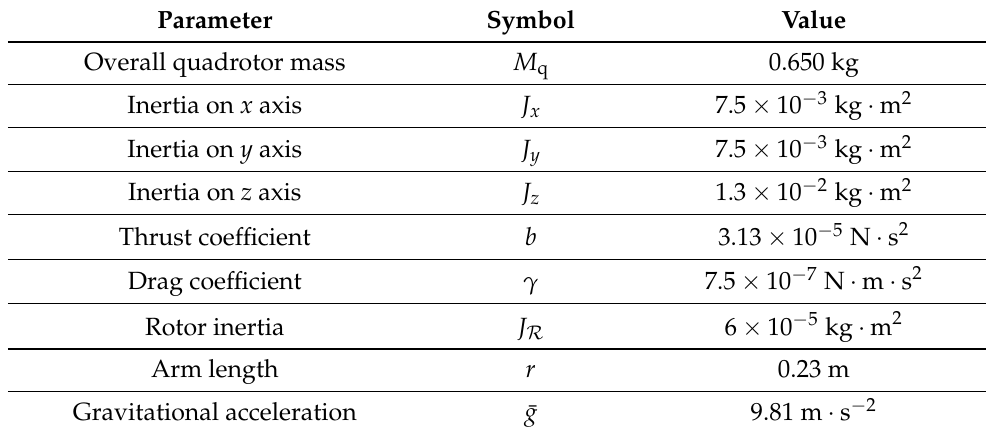
Table 1. Summary table of the OS4 Mini-VTOL quadcopter parameters (SI